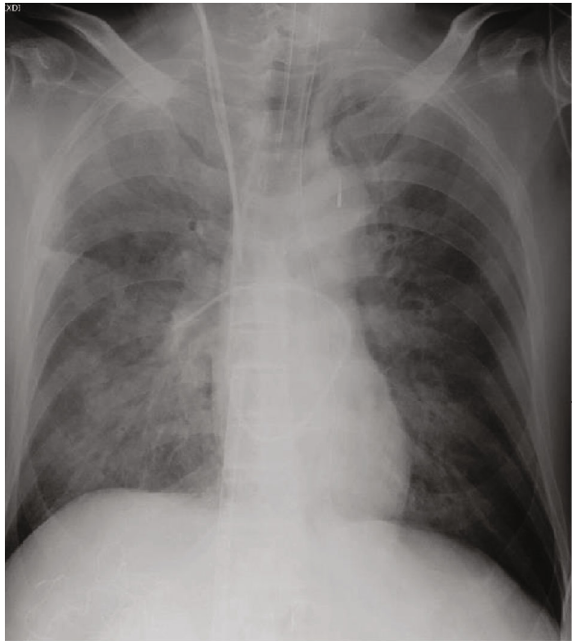
Figure 3: Chest roentgenogram. Chest X-ray showed a severe pulmonary